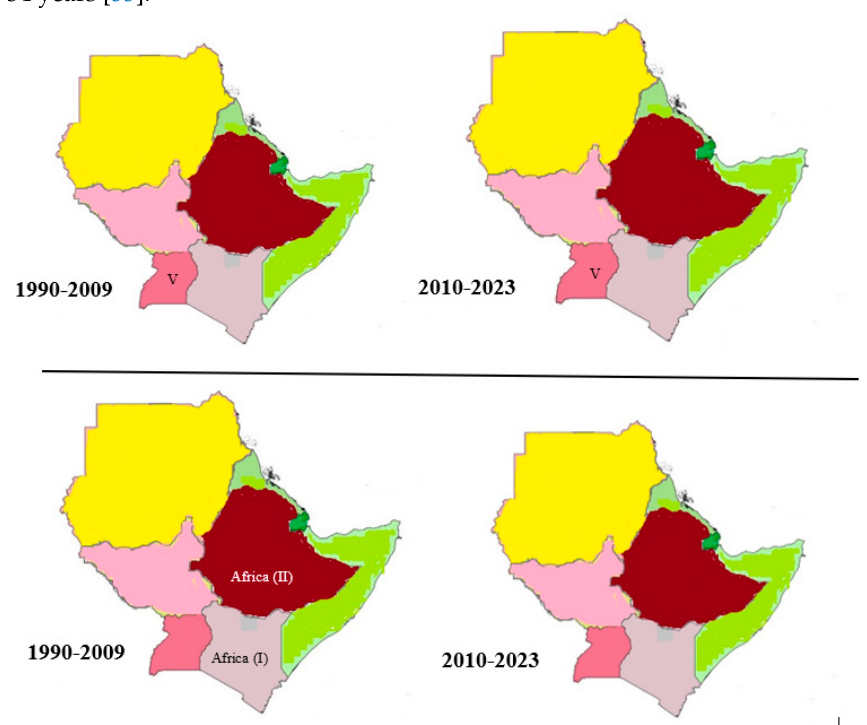
Figure 4. Serotype SAT 3 ( top panel ) and C ( bottom panel ) topotype distribution and evolution in the Horn of Africa countries (1990–2023).